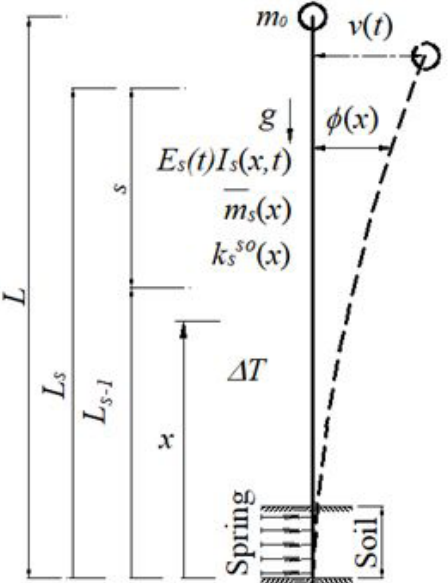
Figure 1. Mathematical model of the